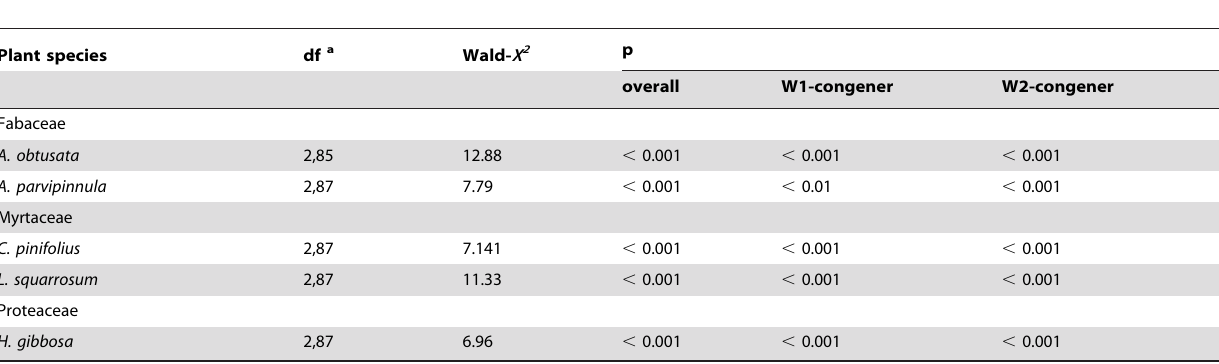
Table 4. Summary statistics for multivariate generalised linear model analyses (mGLM) of feeding guild species richness data, for the entire Coleoptera and Hemiptera guild structure; pair wise comparisons between the two warm sites and a congeneric host plant species in this area are shown.